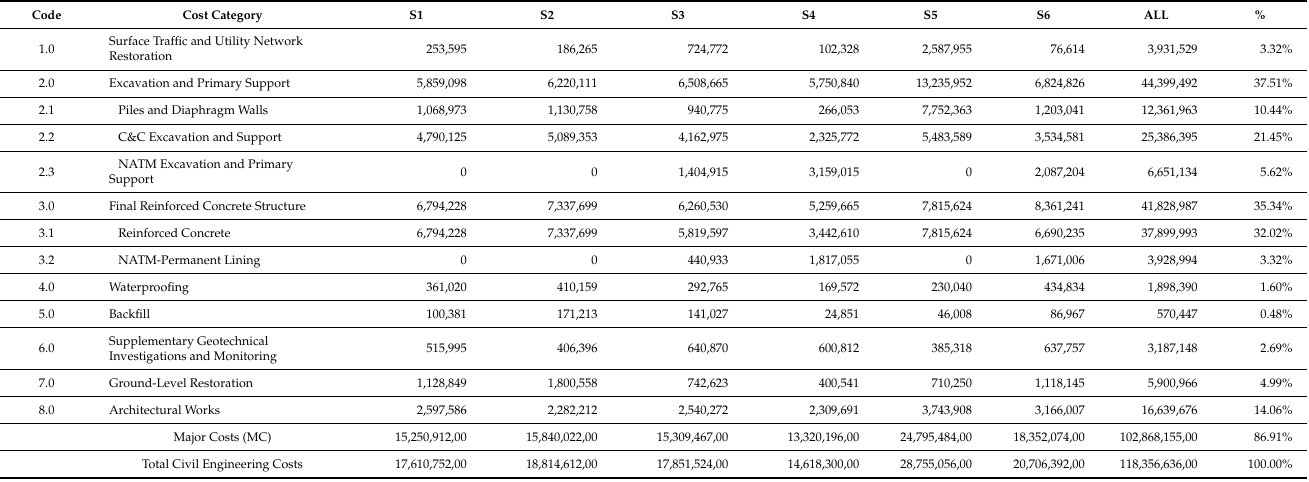
Table 4. Civil engineering cost breakdown in